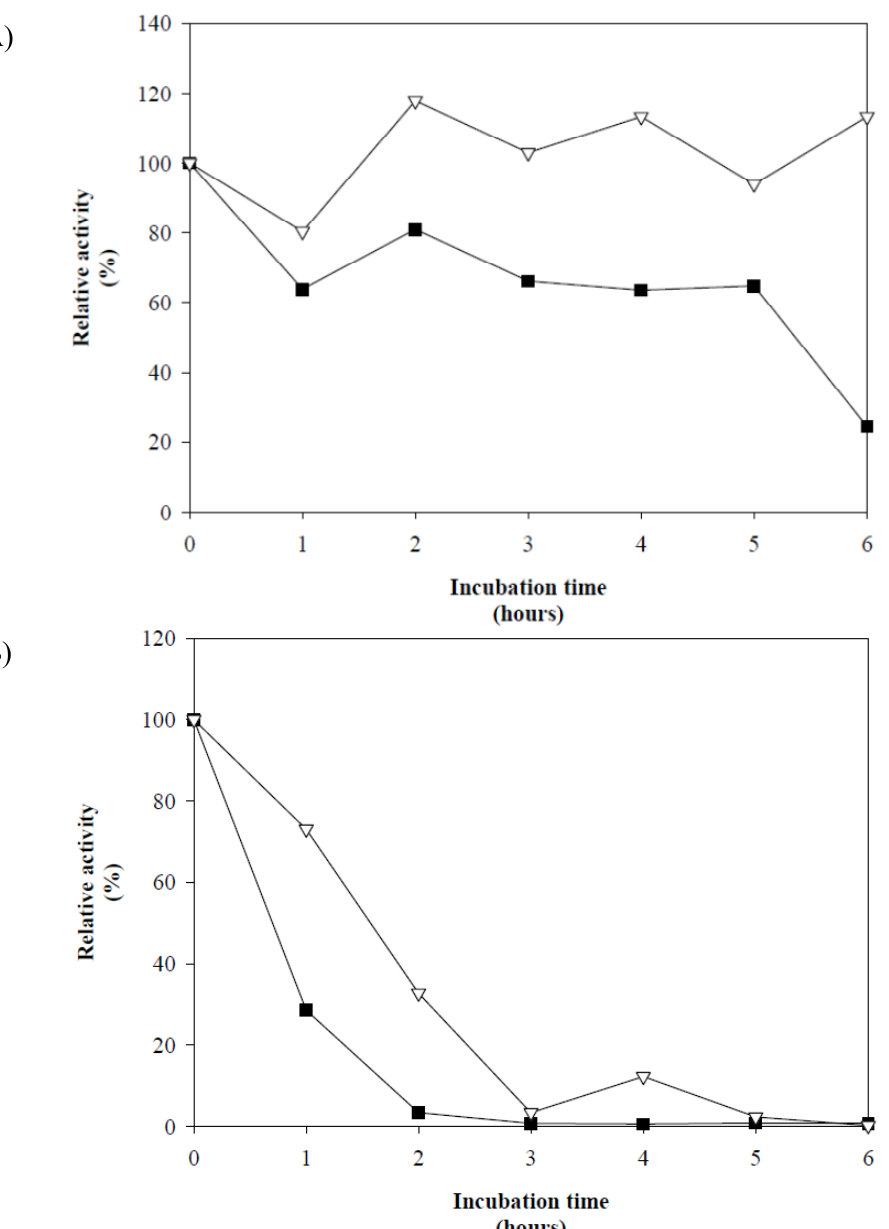
Figure 3. Effect of 20 mmol·L − 1 L -cysteine on the thermostability of purified Xyl-O1 at pH 7.0 and ( A ) 50 °C or ( B ) 55 °C [ ]. The control without L -cysteine [